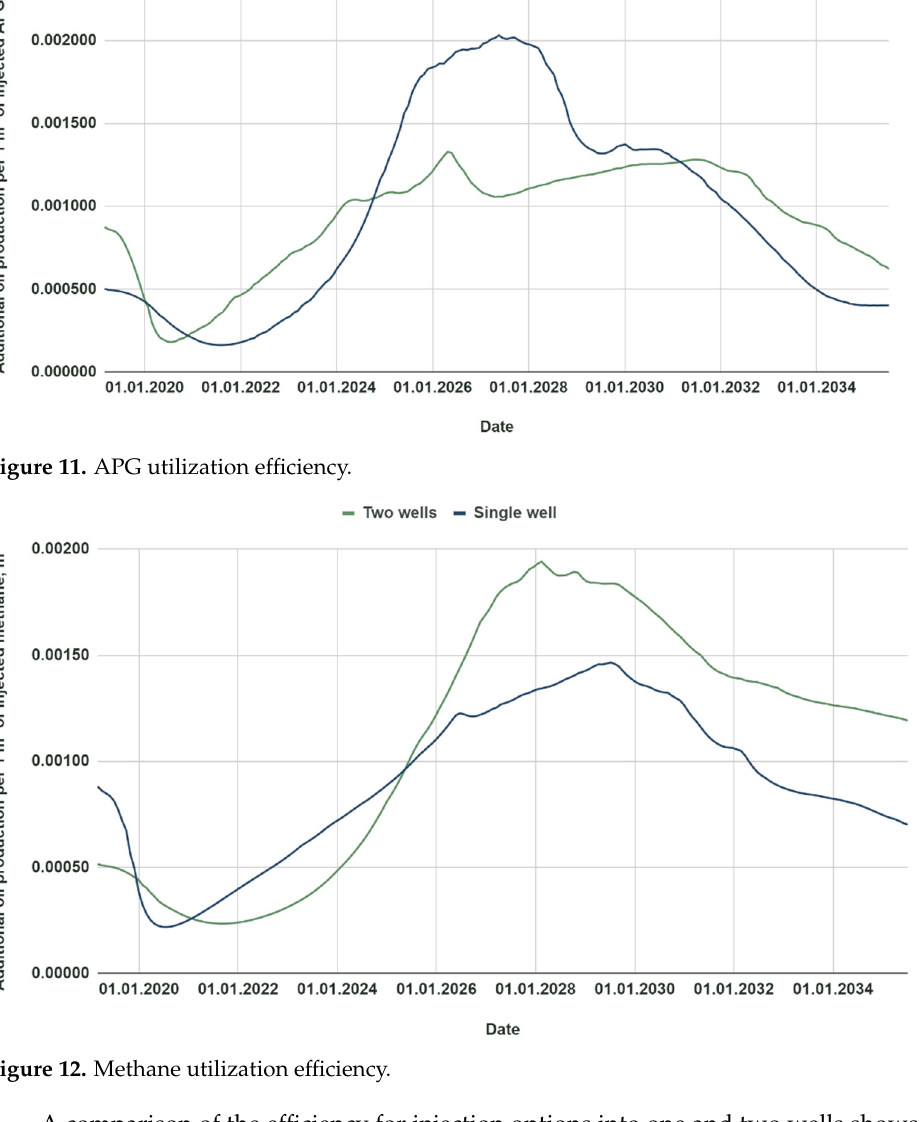
Figure 12. Methane utilization efficiency.